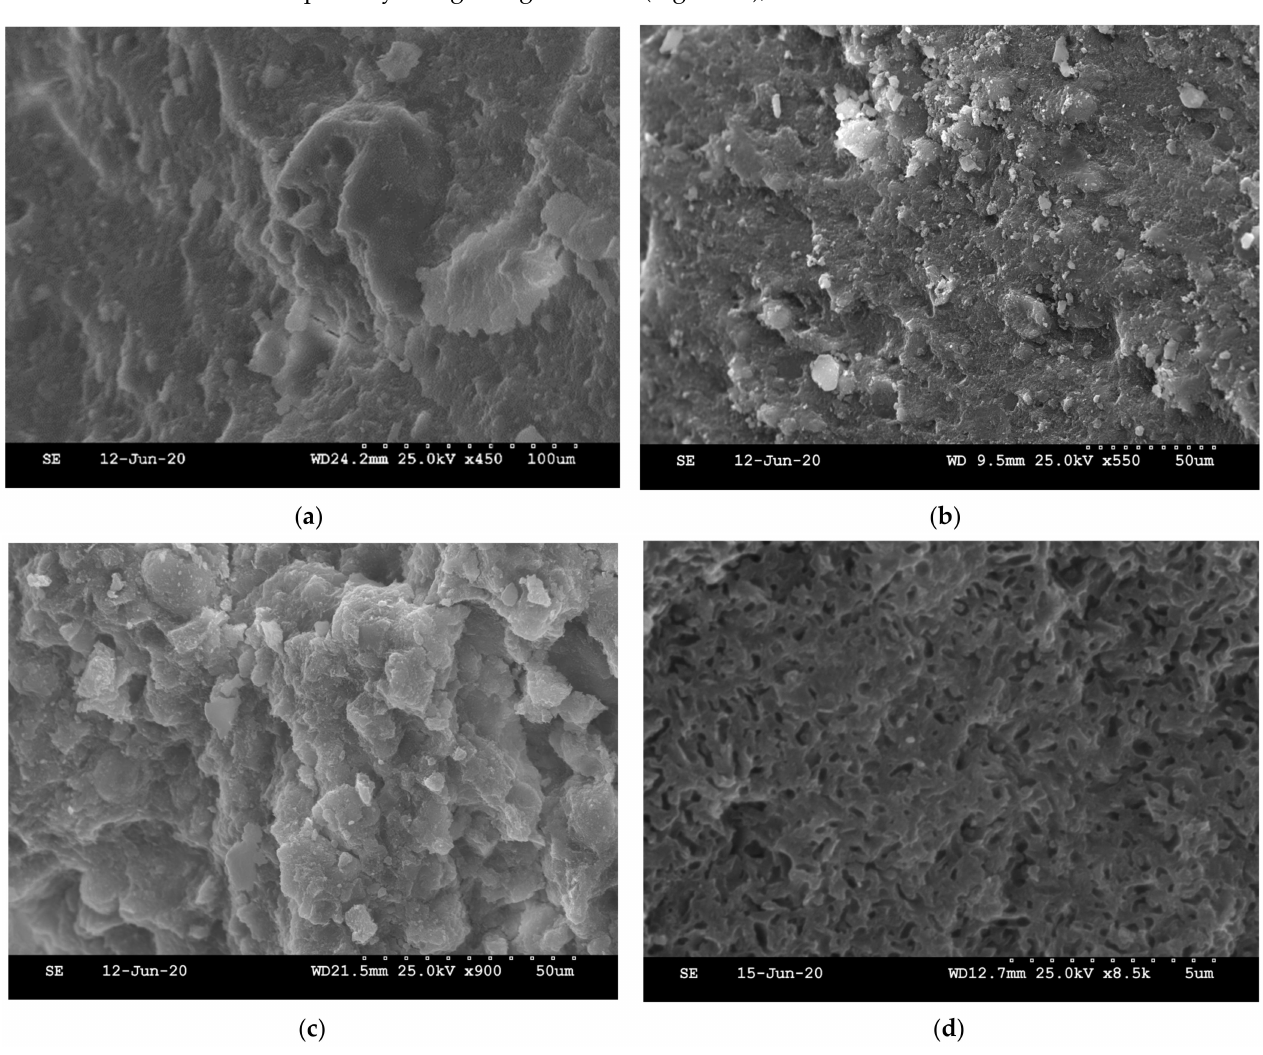
Figure 8. Fresh facture images on SEM of colloidal silica pastes with a 50 ◦ C curing after 4.5 months of hydration: ( a ) and ( c ) M/S = 1.3, ( b ) M/S = 0.78 and ( d ) M/S =